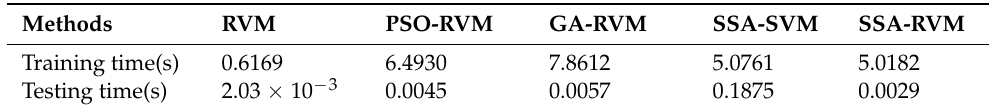
Table 8. Time consumption of different